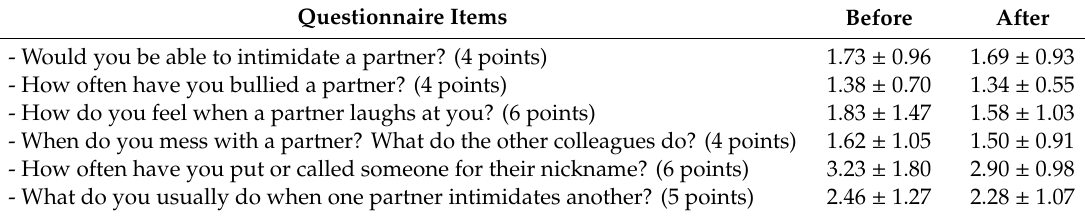
Table 3. Intimidation dimension.